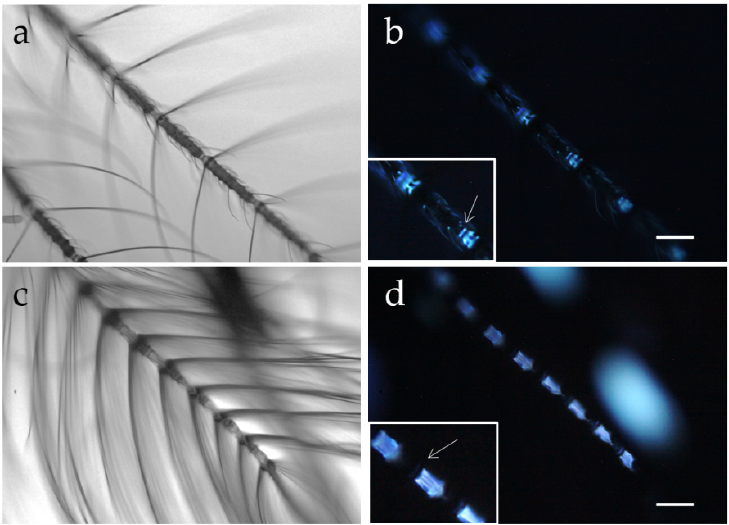
Figure 6. Antennae of female ( a , b ) and male ( c , d ) Ae. albopictus adults, observed under bright field ( a , c ) and fluorescence ( b , d ) microscopic conditions. More numerous and longer fibrillae are observed in males as compared with females, which have more sensilla distributed along the entire length of the antenna. Autofluorescence reveals an additional sexual dimorphism, showing a thin disc (arrow) near a larger cone (magnified in the inset) in each joint of the female antennae, while in the male a very thin blue disc (arrow) can be appreciated near the strong emission arising from the segments of the flagellomers 1–11 and showing a fibrous structural organization. These bluish emissions are relatable to the presence of resilin, as suggested by AF spectral analyses. Bars = 100 μ m. In the light of the previous reports by Saltin and colleagues addressing the importance of antennal components in influencing its mechanical response to sound vibrations